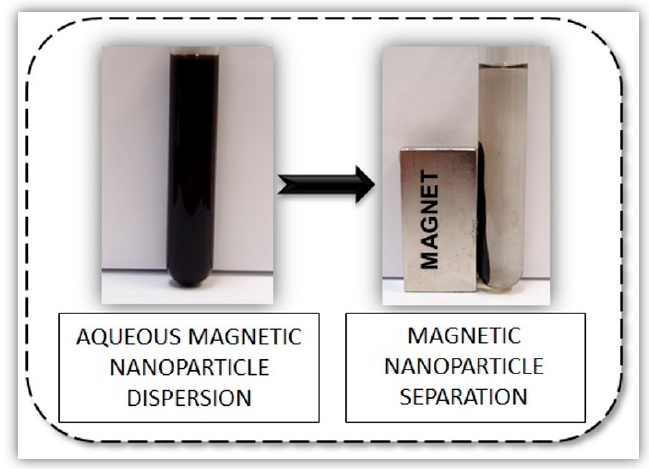
Figure 2. Magnetic properties of maghemite nanoparticles dispersed in water.